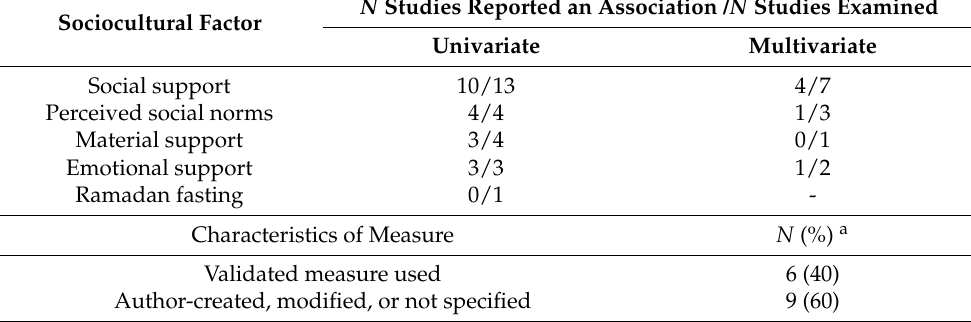
Table 7. Characteristics of studies that measured sociocultural factors ( N =